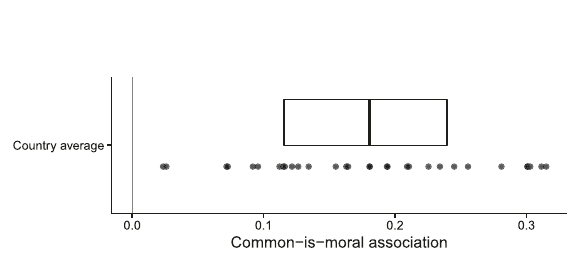
Fig. 1 Plot showing the average within-individual common-is-moral association in 31 countries in the European Values Study. Each dot represents a country. The box indicates the interquartile range, with the dark line in the box indicating the median.